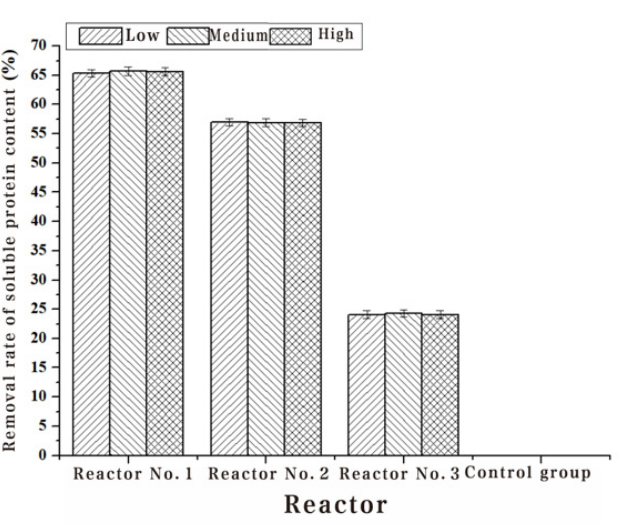
Figure 4. Effect of three addition methods with Phanerochaete chrysosporium on the protein content. Table 5. The MDA content variation in three addition methods with Phanerochaete chrysosporium .